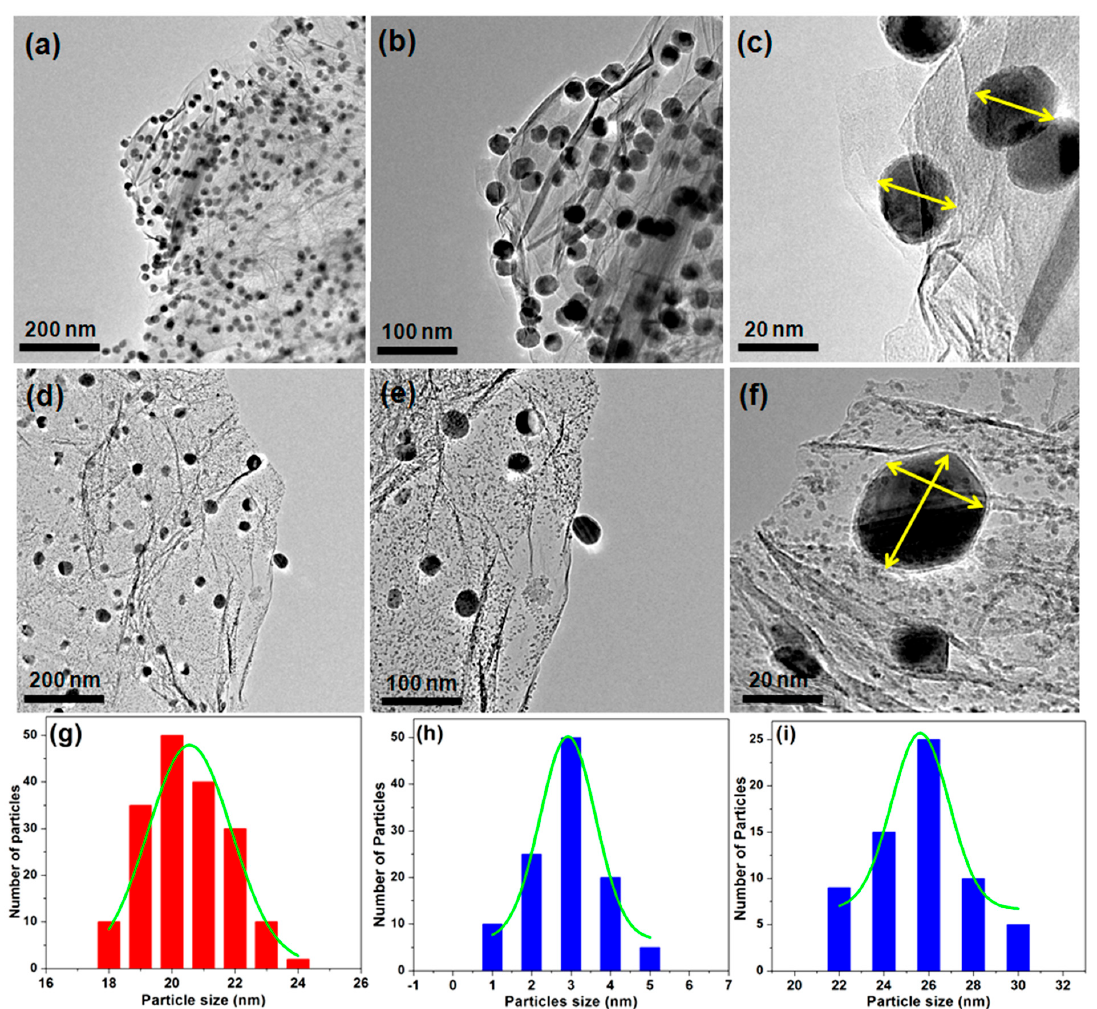
Figure 2. TEM images of ( a , b and c ) Ni/GO-1 and ( d , e and f ) Ni/GO-2, and particle-size distribution histogram of NiO nanoparticles in (g) Ni/GO-1 and (h and i) Ni/GO-2.